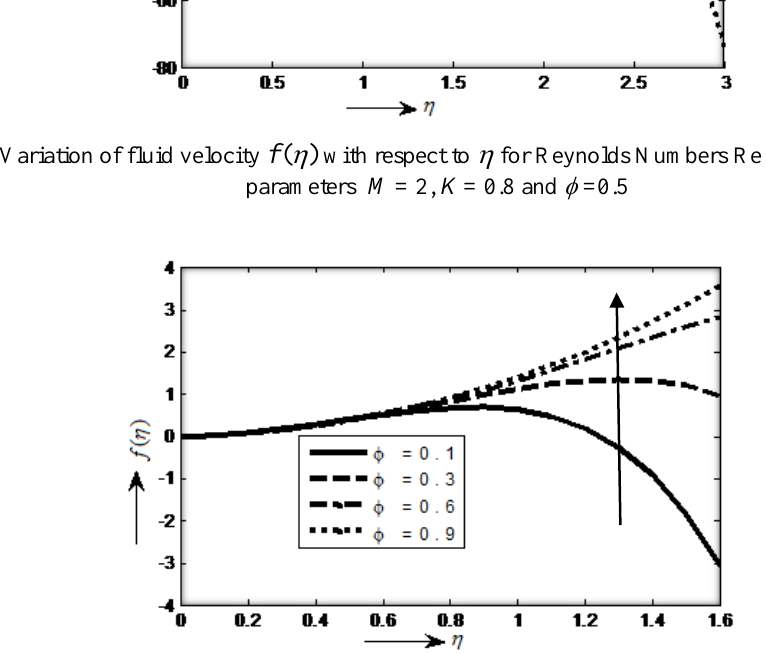
Figure 6. Variation of fluid velocity f (  ) against  for slip coefficients  (0.1, 0.3, 0.6, 0.9) by taking parameters M = 2, K = 0.8 and Re =